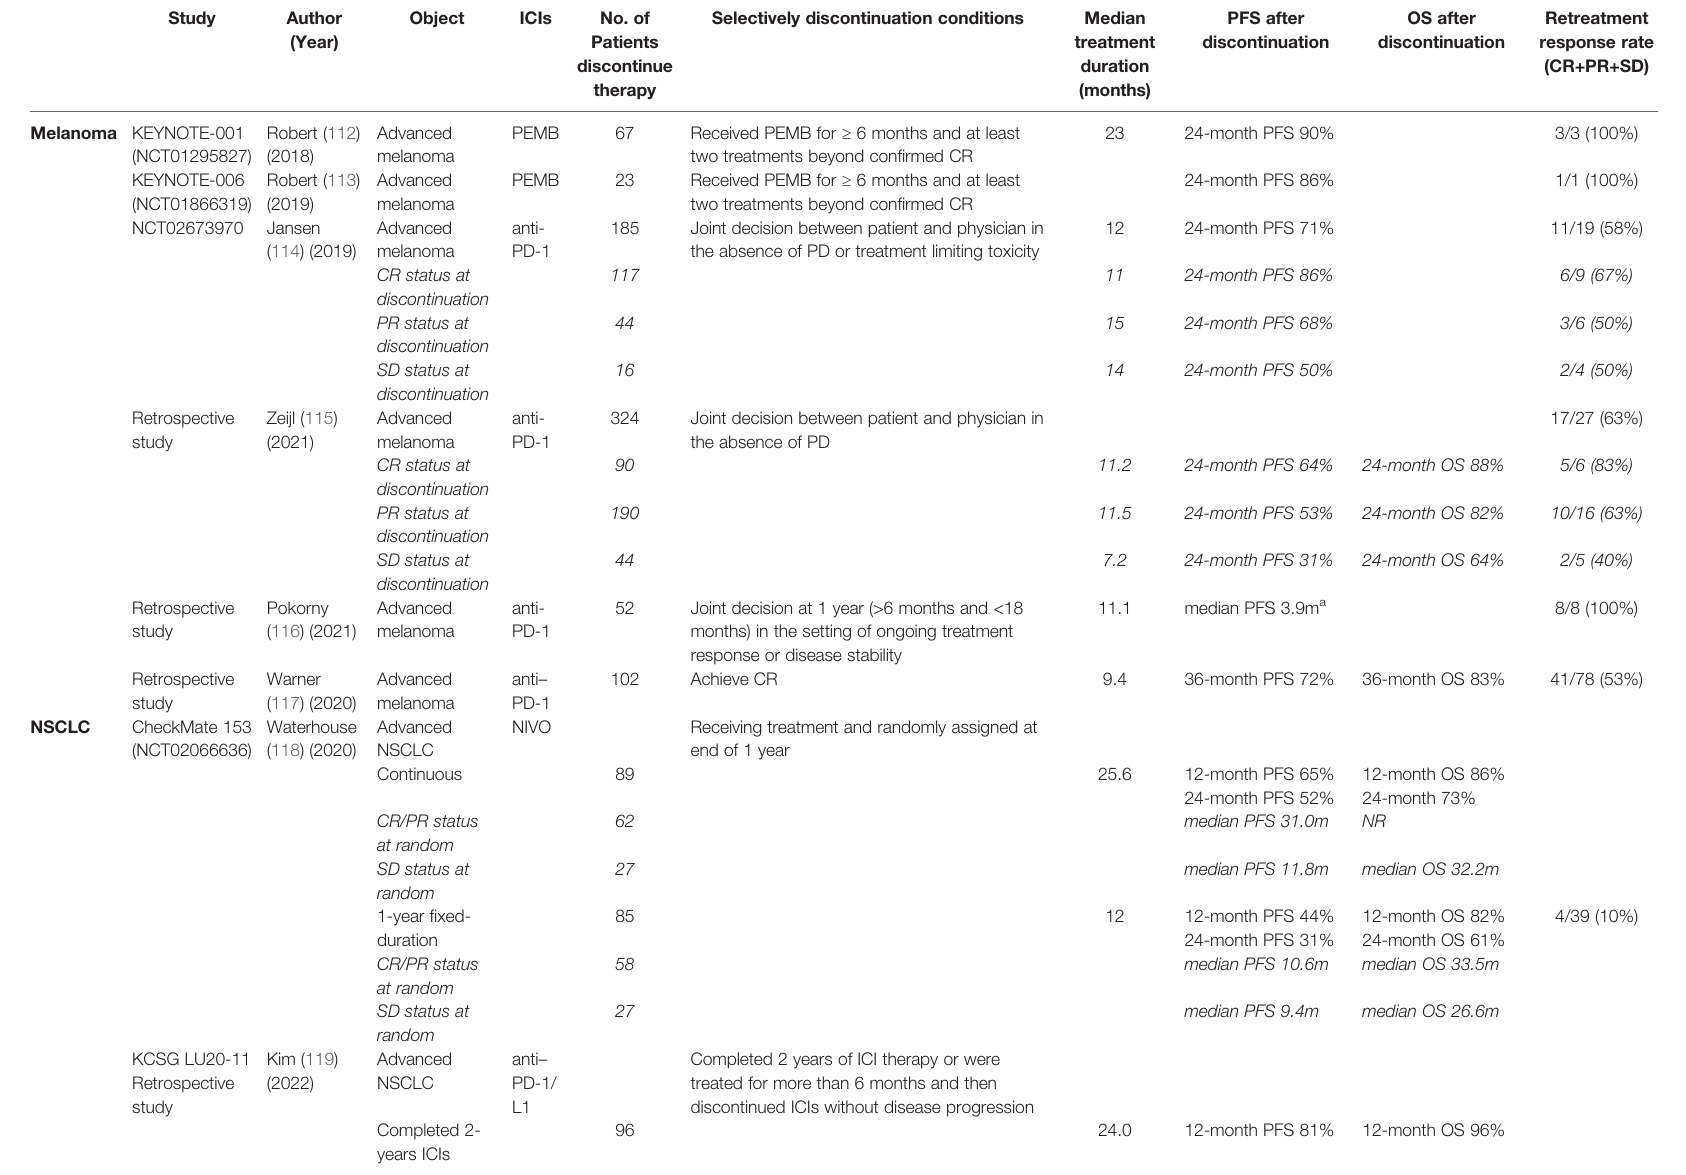
TABLE 2 | Retrospective and Prospective Studies of Selectively Discontinuation of